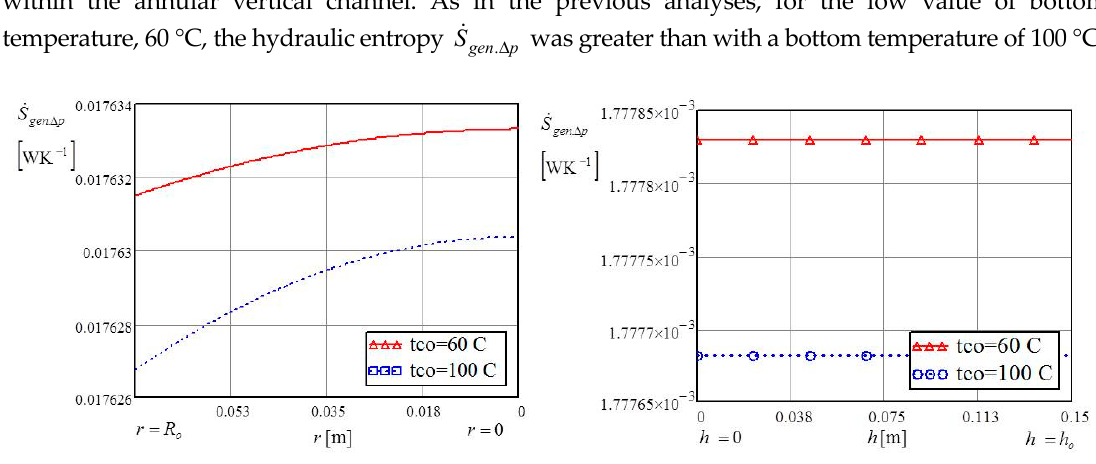
Figure 11. The hydraulic entropy of the individual influence of the bottom and the vertical annular